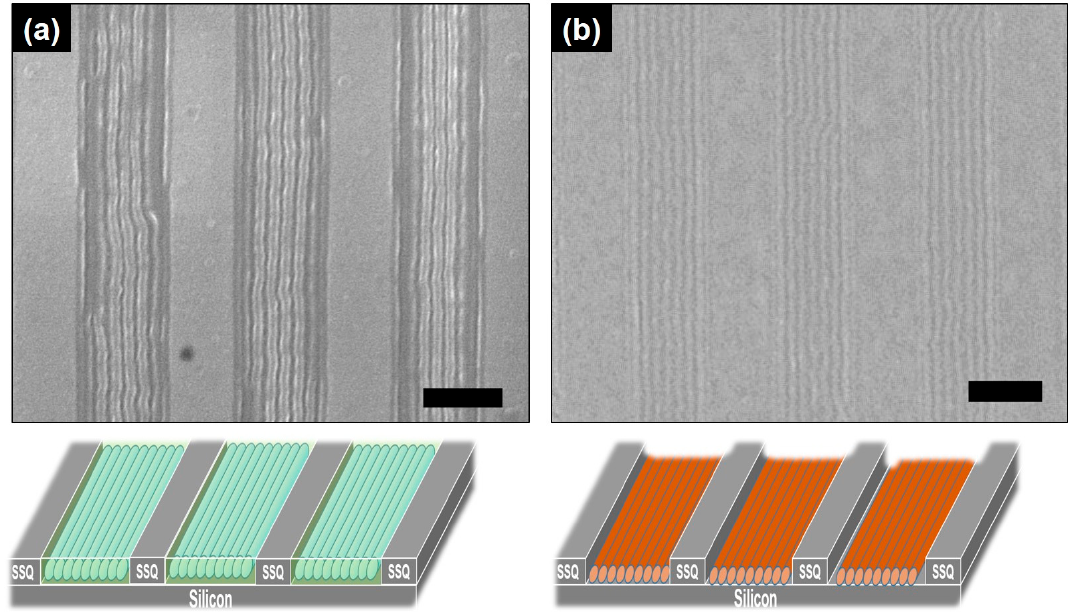
Figure 3. Top-down SEM images of ( a ) aligned PS- b -P4VP BCP features after solvent vapor annealing and ethanol “activation” in SSQ trenches nanoimprinted silicon substrates and ( b ) WO 3 nanowires following metal salt inclusion and UV/O 3 . Scale bars represent 250 nm.